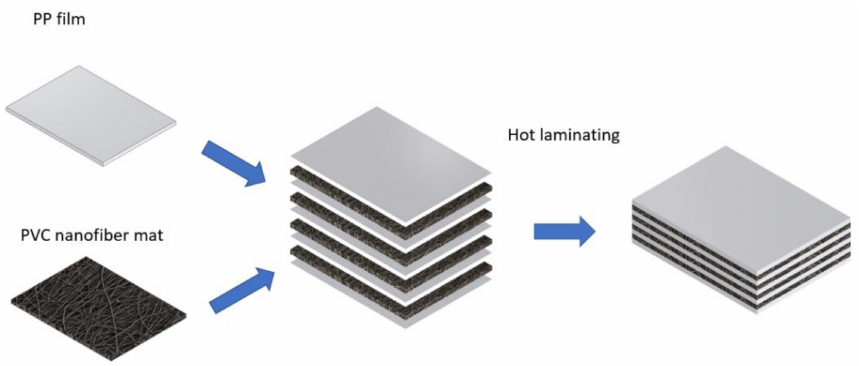
Figure 10. The schematic diagram for the fabrication of composite from PP films and PVC nanofiber